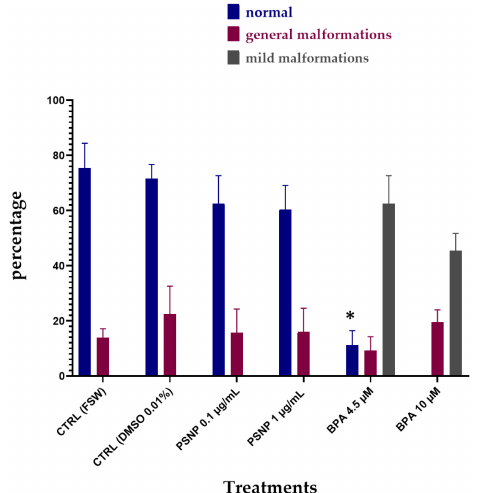
Figure 1. The percentage (%) of normal hatched larvae (blue), larvae with general malformations (red) and with mild malformations (reduced pigmentation of otolith and ocellus, grey) upon single exposure of 22 hpf to PS NPs (0.1 µ g/L and 1 µ g/L) and BPA (4.5 and 10 µ m) in FSW. Bars show values expressed as mean ± Standard Deviation. * indicates values that are significantly different compared to controls (2-way ANOVA, p <